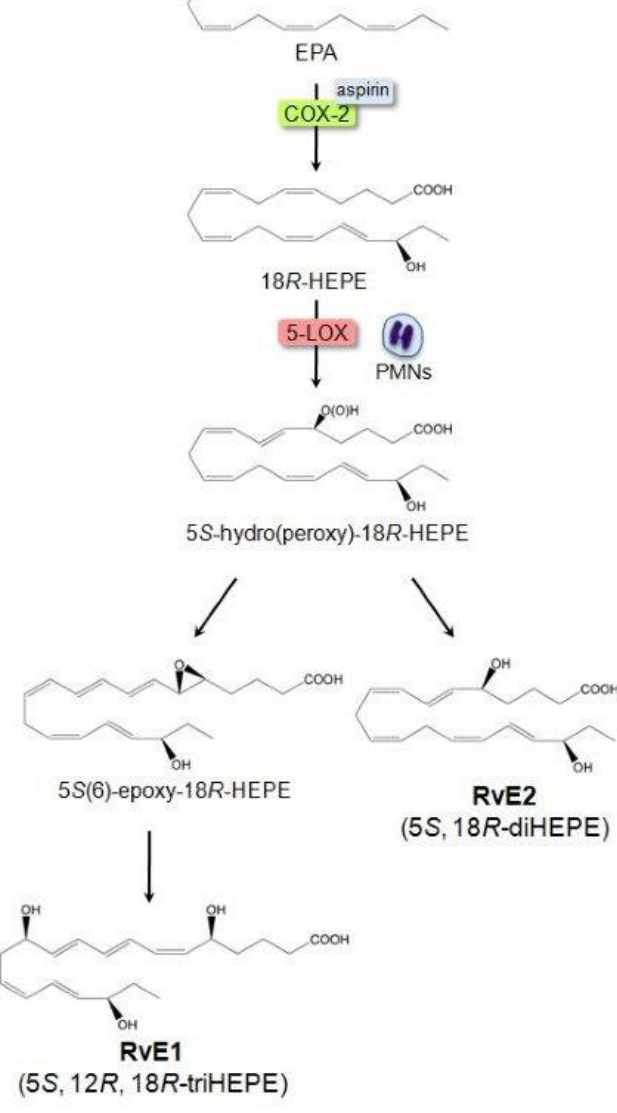
FIGURE 2 . Biosynthetic scheme proposed for E-series resolvins. EPA is oxygenated at the carbon-18 position via the action of aspirin-acetylated COX-2 to form 18 R -HEPE, which is subsequently oxygenated to form 5 S - hydro(peroxy)-18 R -HEPE via 5-LOX activity. The 5 S -hydroperoxy group is either converted to an 5,6-epoxide intermediate to form RvE1 or reduced to a 5 S -hydroxyl group to form